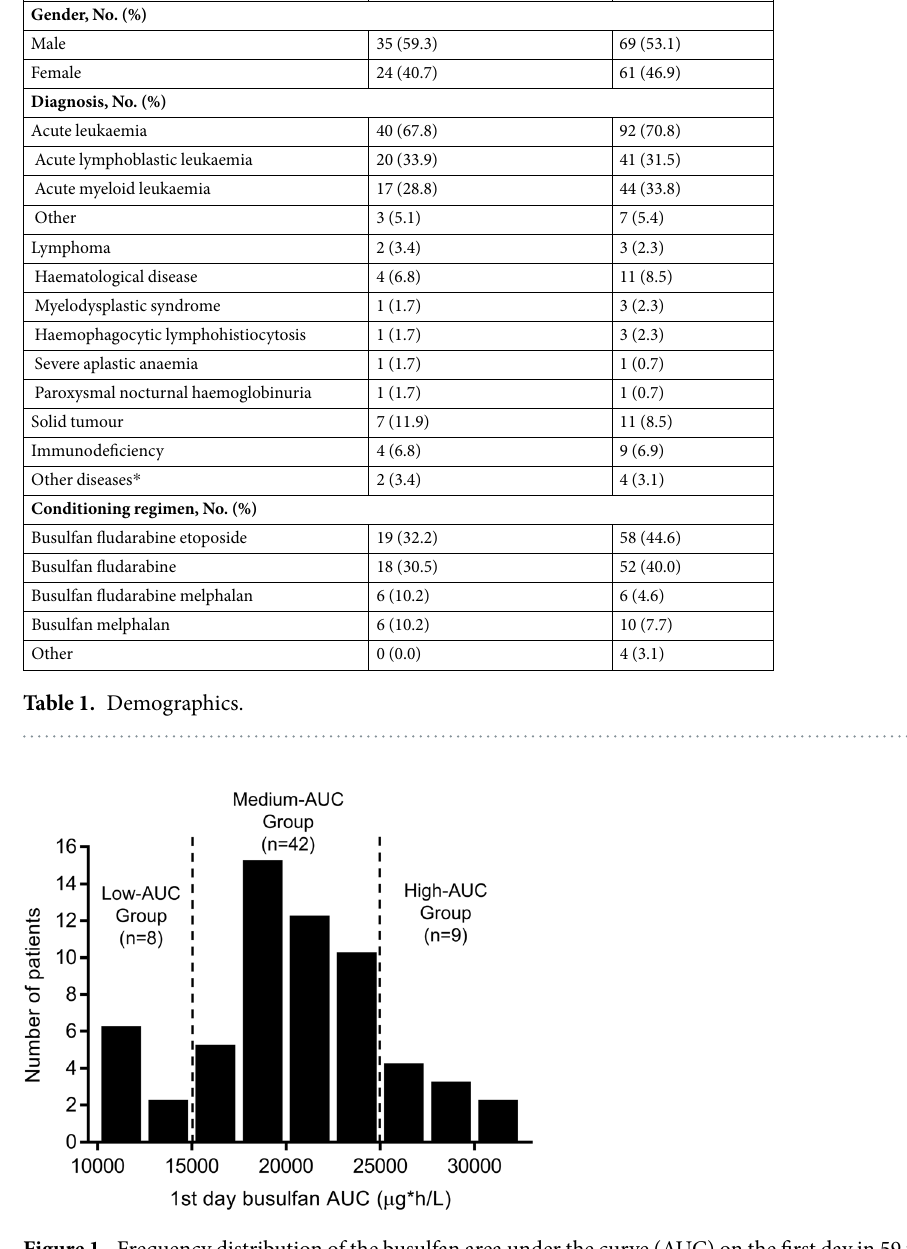
Figure 1. Frequency distribution of the busulfan area under the curve (AUC) on the first day in 59 paediatric patients. The AUC ranged from 11,668 to 31,197 μ g·h/L (median 20,037 μ g·h/L, % covariate = 23.5%) after infusing 120 mg/m 2 busulfan on the first